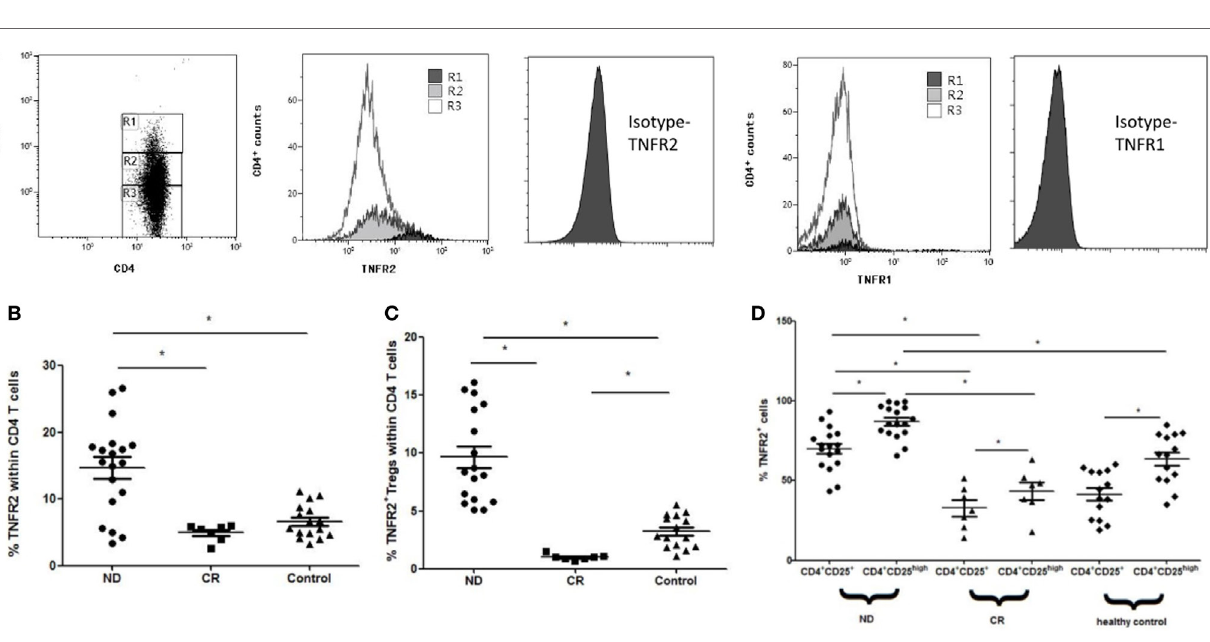
FigUre 5 | Levels of tumor necrosis factor receptor (TNFR)1 or TNFR2 expression on peripheral blood (PB) CD4 + T cells in acute myeloid leukemia (AML) patients and healthy controls. CD4 + T cells were stained for CD4, CD25, TNFR1, and TNFR2, and analyzed with FACS. (a) Representative flow plots of TNFR1 and TNFR2 expression by Rl (CD4 + CD25 high T cells), R2 [CD4 + CD25 + regulatory T cells (Tregs)], and R3 (CD4 + CD25 − T cells) in PB of newly diagnosed (ND) AML patients. TNFR2 was preferentially expressed on CD4 + CD25 high T cells, TNFR1 expression was unchanged. Isotypes for TNFR1 and TNFR2 were also performed. (B) The expression levels of TNFR2 on PB CD4 + T cells in AML patients and healthy controls. The TNFR2 expression on PB CD4 + T cells in ND AML was significantly higher than that in complete remission (CR) patients and controls. (c) The frequency of TNFR2 + Tregs in PB CD4 + T cells from ND AML patients was also significantly higher than that in healthy controls and CR patients. (D) The proportion of TNFR2 + cells by CD4 + CD25 + Tregs and CD4 + CD25 high T cells in AML patients and healthy controls. TNFR2 was preferentially expressed on CD4 + CD25 high T cells compared with Tregs in PB of ND, CR patients, and controls. TNFR2 expressions on both PB CD4 + CD25 + Tregs and CD4 + CD25 high T cells in ND patients were significantly higher than those in CR patients and controls.